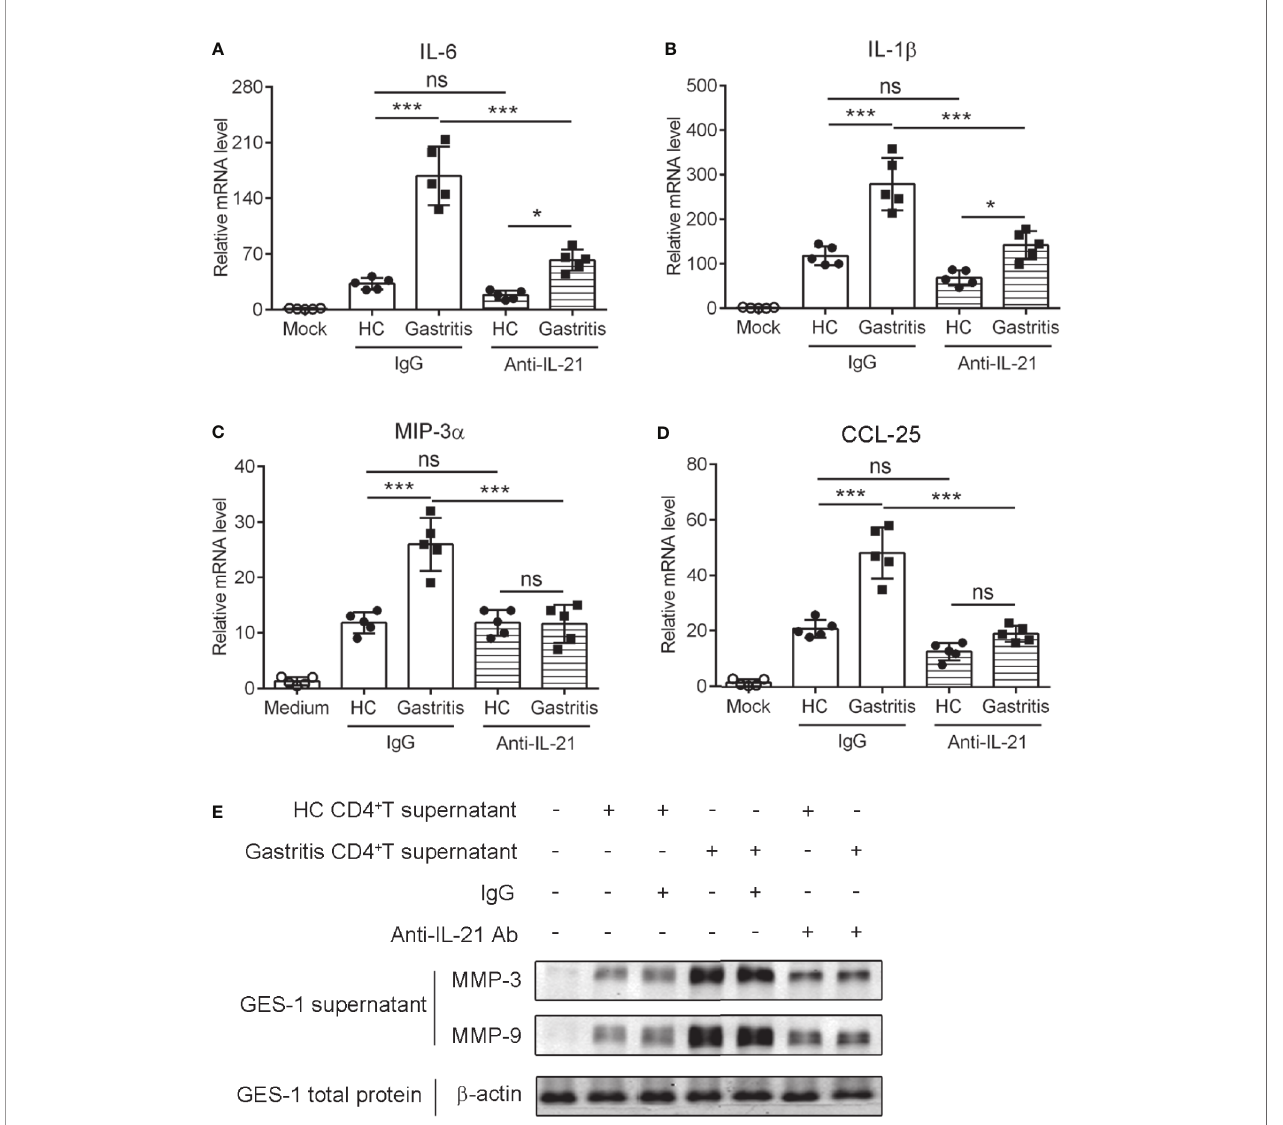
FIGURE 6 | IL-21 + TFH-like cells induced the expression of pro-in fl ammatory cytokines and matrix metalloproteinases in human gastric epithelial cells. The gastric CD4 + T cells were isolated from the gastric mucosa of Helicobacter pylori -positive patients and healthy controls and stimulated with CD3 agonist Ab or recombinant GITRL protein. At 3 days later, the culture supernatant was collected. GES-1 cells were treated with 20% culture supernatant of gastric CD4 + T cells with the addition of control IgG or anti-IL-21-neutralizing Ab for 24 h. The mRNA expressions of IL-6 (A) , IL-1 bb ; (B) , MIP-3 aa (C) , and CCL-25 (D) were determined by real-time PCR. (E) MMP-3, MMP-9, and b -actin expression in the culture supernatants or total extracts of GES-1 cells was detected by western blot. One-way ANOVA was used to compare among three or multiple groups. Data are shown as mean ± SD from at least three independent experiments. ns, P > 0.05; * P < 0.05; *** P <